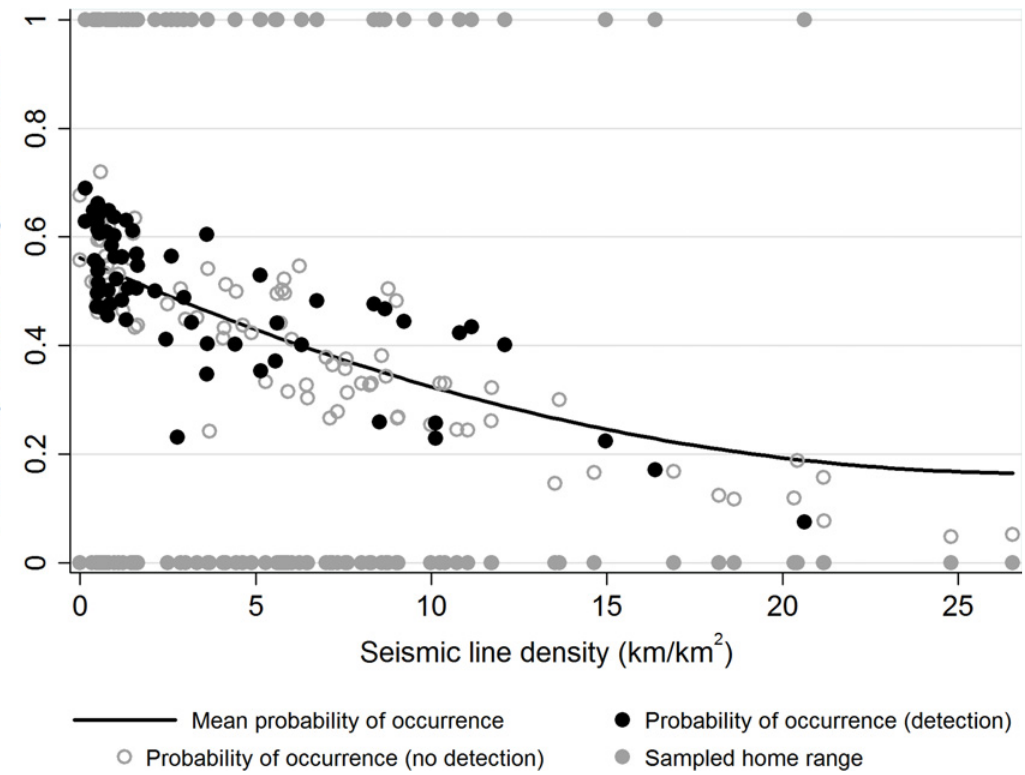
Fig 3. Probability of American marten occurrence relative to seismic line density. The probability that American marten ( Martes americana ) occur at the home range is significantly influenced by seismic line density in northwest Canada. As seismic line density increases, the mean probability of occurrence declines.